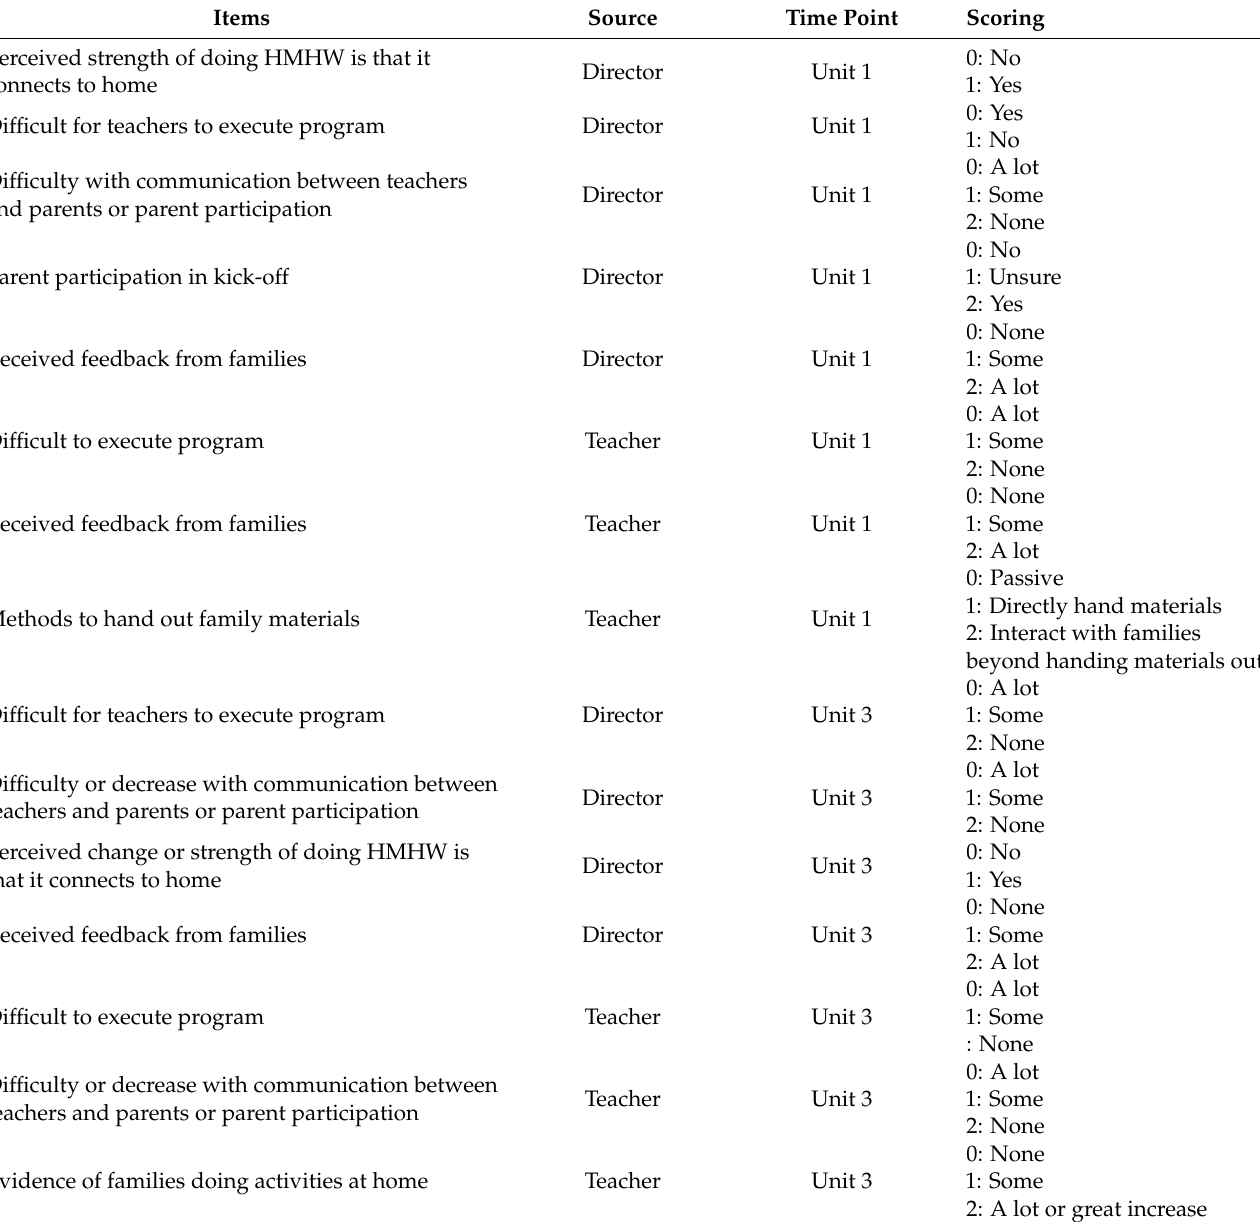
Table 2. Center-level measure and scoring of parent engagement for Healthy Me , Healthy We (HMHW) from structured interviews during technical assistance